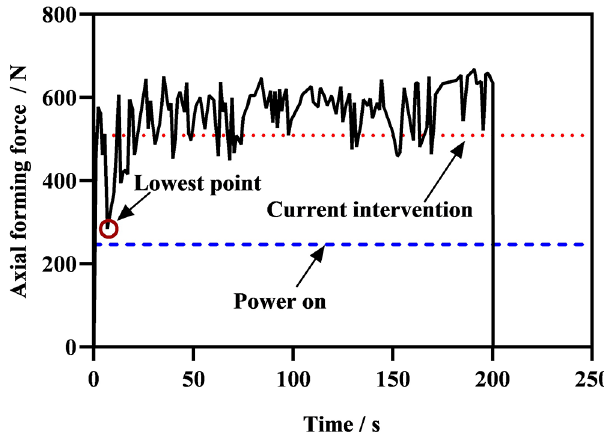
Fig. 8. Action results of double critical value.